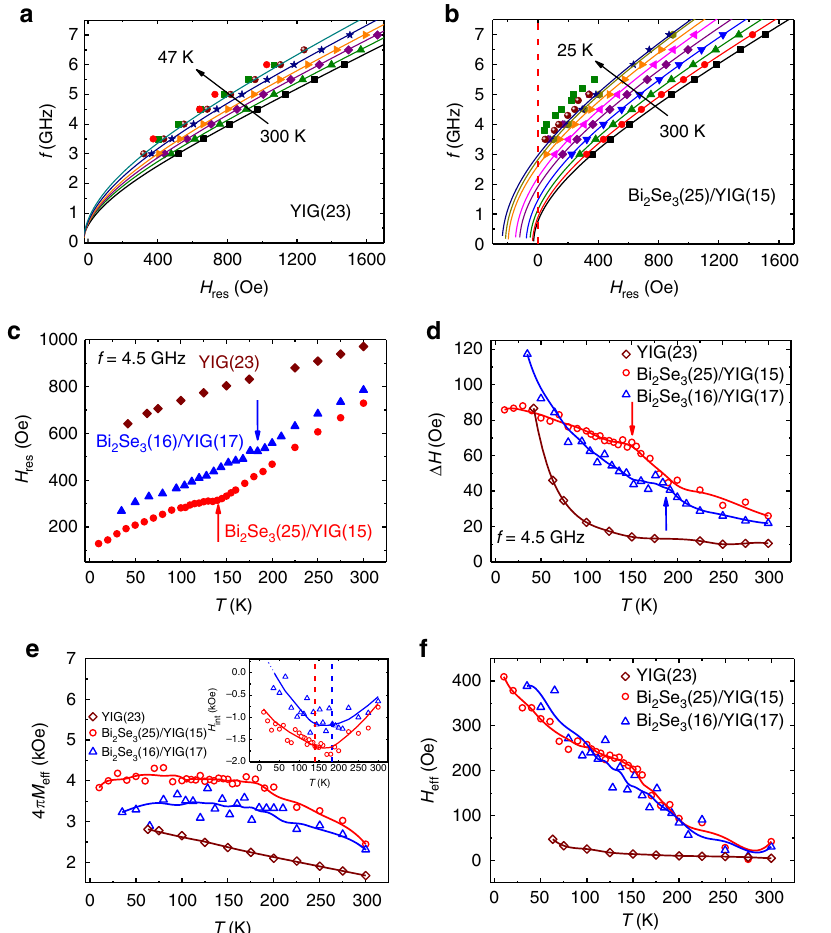
Fig. 3 Temperature dependence of FMR characteristics of Bi 2 Se 3 /YIG. a , b f vs. H res data for various T for YIG(23) and Bi 2 Se 3 (25)/YIG(15), respectively. Solids lines are fi tted curves using Eq. (2). c , d , e , and f T dependence of H res , Δ H , 4 π M eff , and H eff of one YIG(23) single layer and two Bi 2 Se 3 /YIG bilayer samples, Bi 2 Se 3 (25)/YIG(15) and Bi 2 Se 3 (16)/YIG(17), respectively. The arrows in c and d denote the position of the hump-like features. Solid lines are guides of the eyes obtained by properly smoothing the experimental data. The inset of e shows the T dependence of H int . The dashed lines indicate the hump position shown in c and